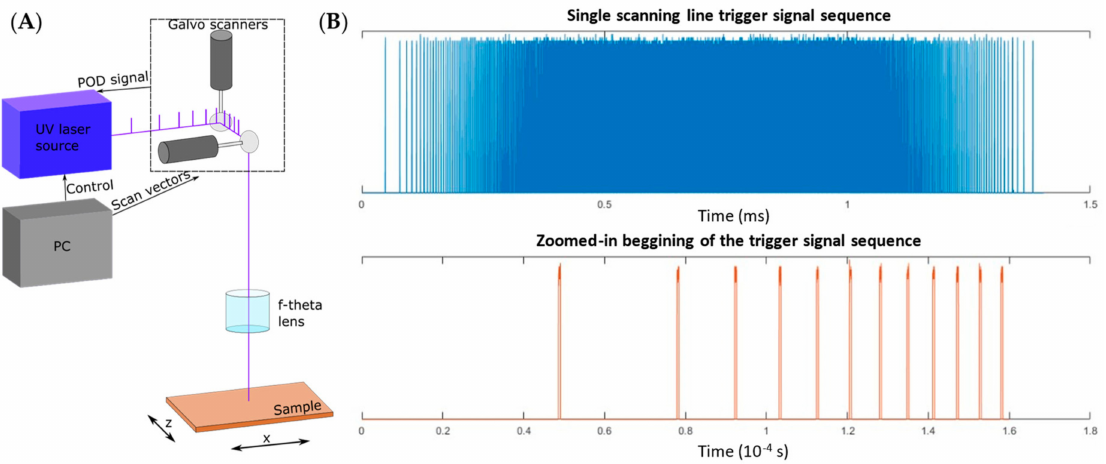
Figure 1. ( A ) Experimental setup schematics. ( B ) POD sequence received from the galvo scanners, based on scanning a 15 mm long straight line at maximal velocity of 20 m/s. Lower frequencies at the beginning and the end correspond to scanner acceleration